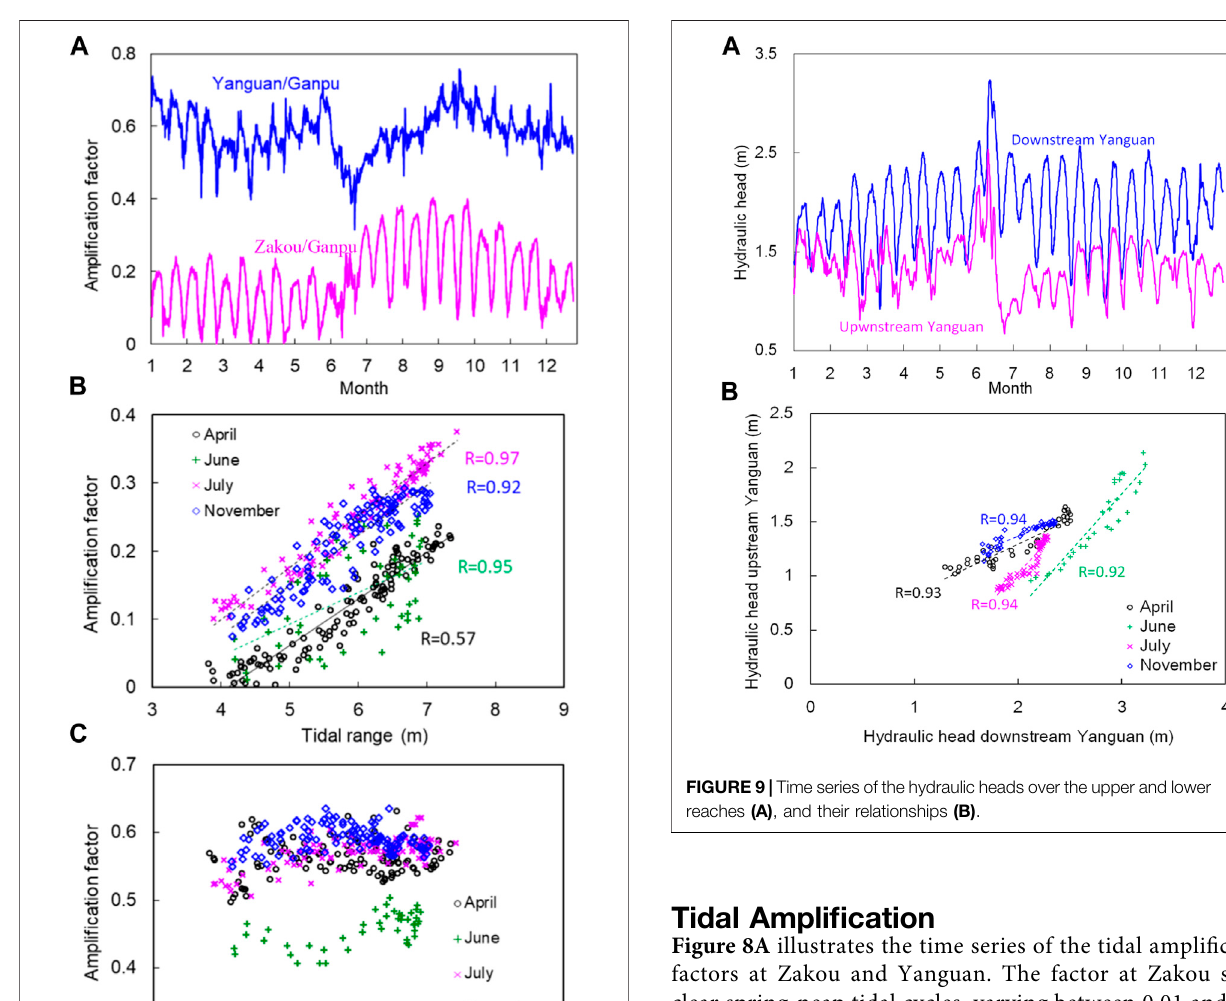
Frontiers in Earth Science |